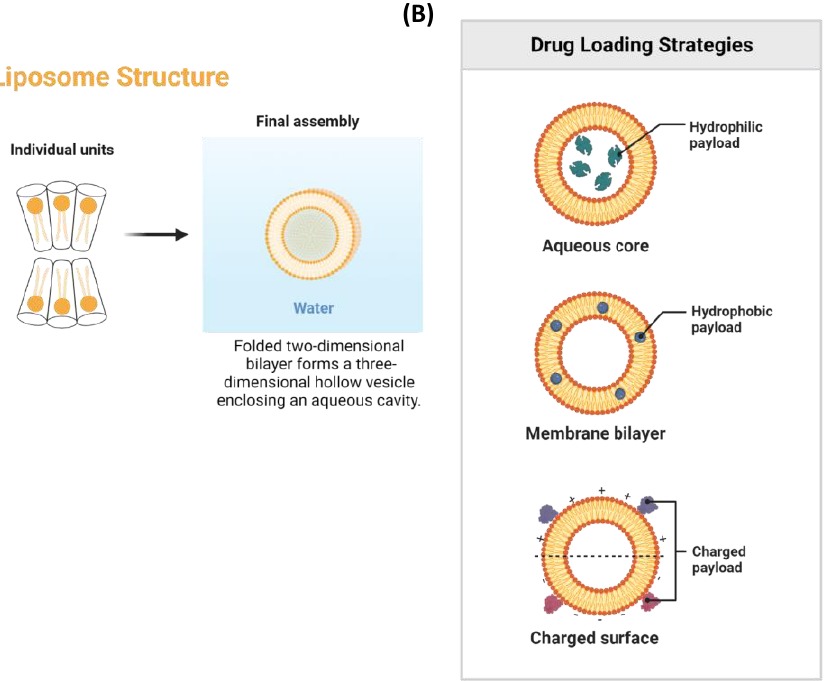
Figure 5. ( A ) Liposomal structure, ( B ) Various drug loading strategies with liposomes. Created with BioRender.com accessed on 24 January 2023.